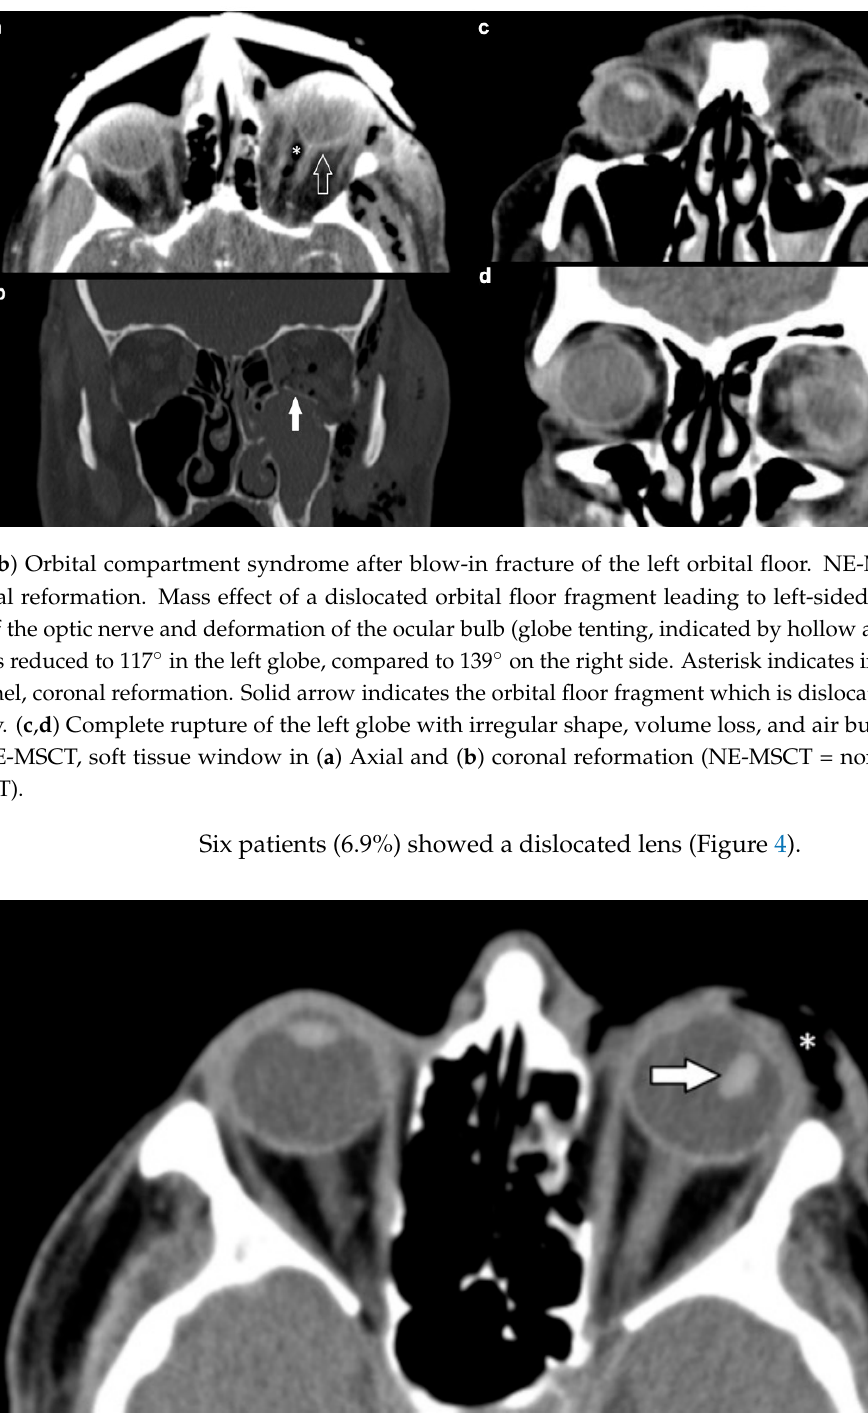
Figure 4. Dislocated left lens (indicated by arrow) and lateral rotation of about 70 degrees. Asterisk (*) indicates periorbital soft tissue emphysema due to a concomitant orbital floor fracture. NE-MSCT, soft tissue window, axial reformation (NE-MSCT = non-contrast-enhanced multi-slice